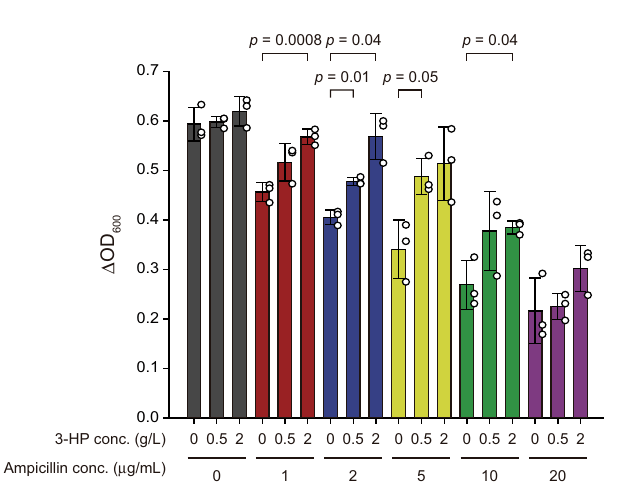
Fig.3|3-HPdependentgrowthcontrolofthemicrobialconsortiuminpresence ofampicillin. Comparisonof biomassformation ( Δ OD 600 , the differenceinOD 600 values at 0h and 24h) in various combinations of 3-HP (0, 0.5, and 2g/L) and ampicillin (0, 1, 2, 5, 10, and 20 µ g/mL) concentrations. Error bars represent the standard deviations of triplicate biological experiments ( n =3) and their center indicates a meanvalue. P values were calculated using Student ’ s t-test (two-tailed). White dot indicates actual data point. Source data are provided as a Source Data fi le.